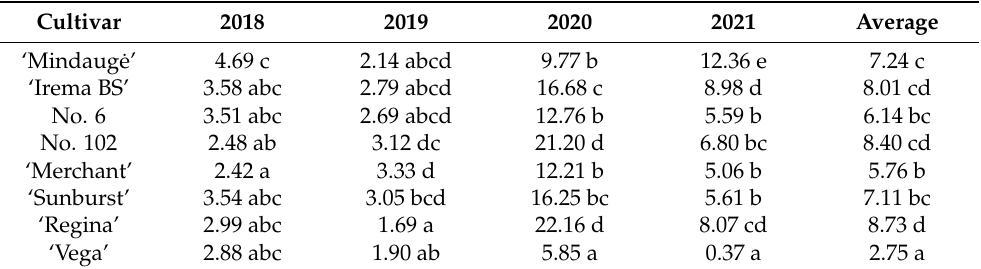
Table 3. Sweet cherry fruit yields (t/ha). Values marked with different letters are statistically different within the columns ( p ≤